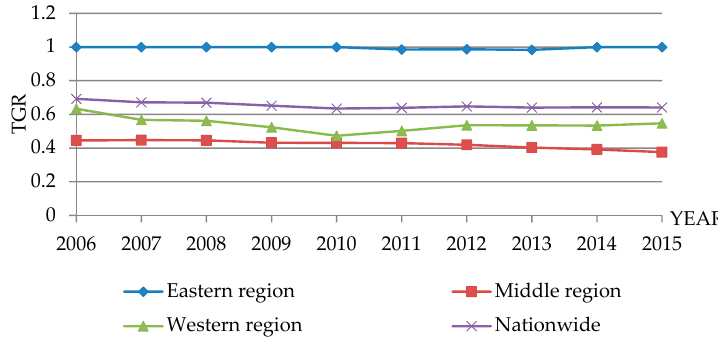
Figure 4. Technology gap ratio (TGR) of three regions during 2006–2015.